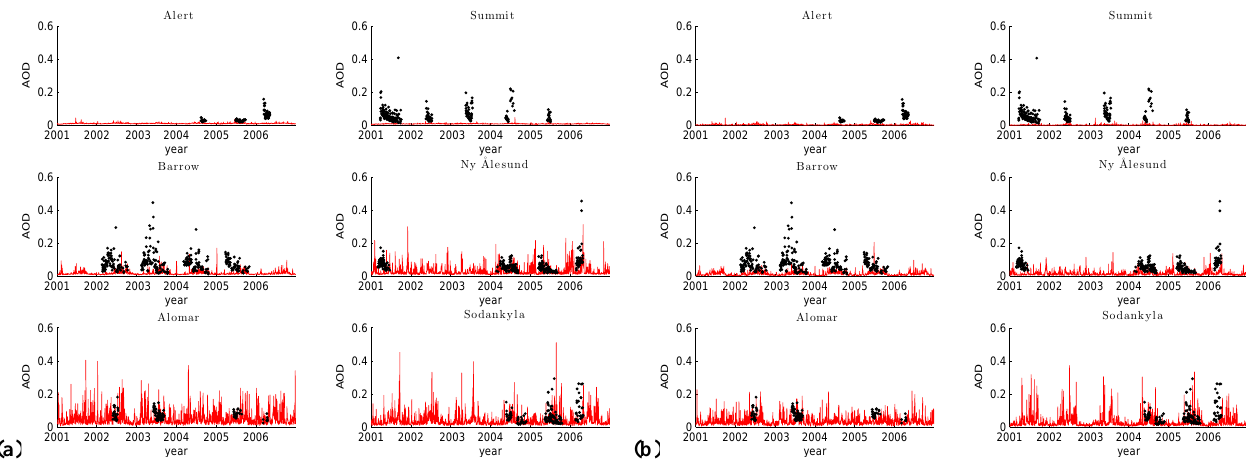
Fig. 3. Time series of daily mean of AOD (550nm) at the indicated Arctic sites. The black symbols are the observations and the continuous lines the model results: panel (a) ECHAM5-HAM (EIPCC emissions) results; panel (b) results obtained using TM5. The station data for AOD were measured at 500nm and interpolated to 550nm using the observed ˚Angstr¨om